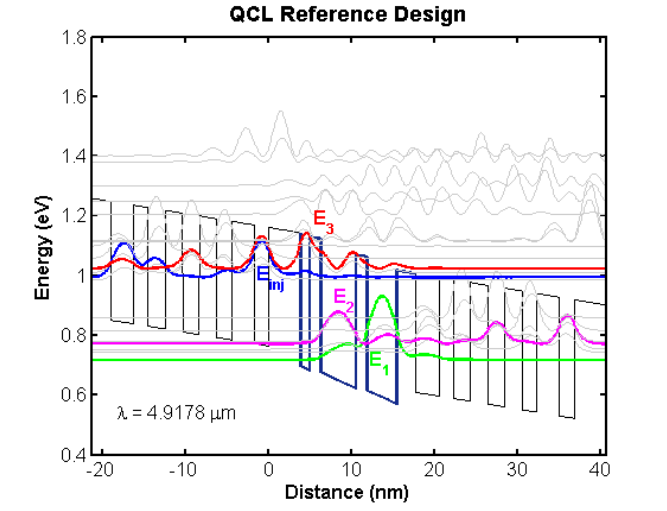
Figure 4. Al x Ga 1 − x As/In y Ga 1 − y As QC laser reference design, adopted from [27] with alloy proportions changed to x = 0.25 and y = 0.1 and simulated on GaAs (111).